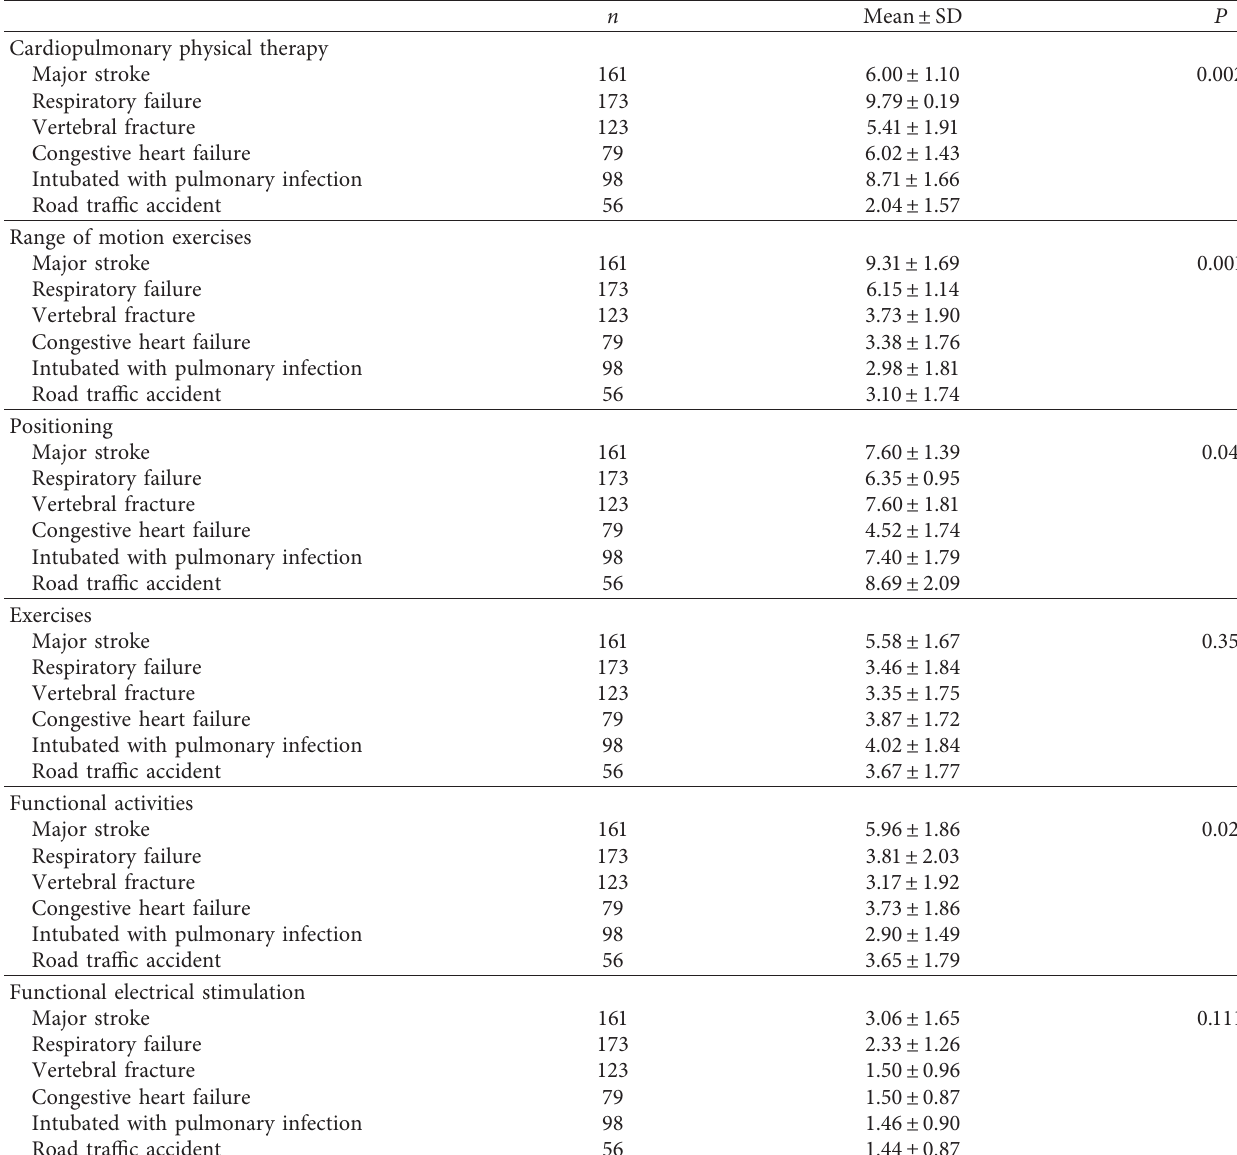
Table 4: Effect of clinical cases scenario on preference of physical therapy treatment.